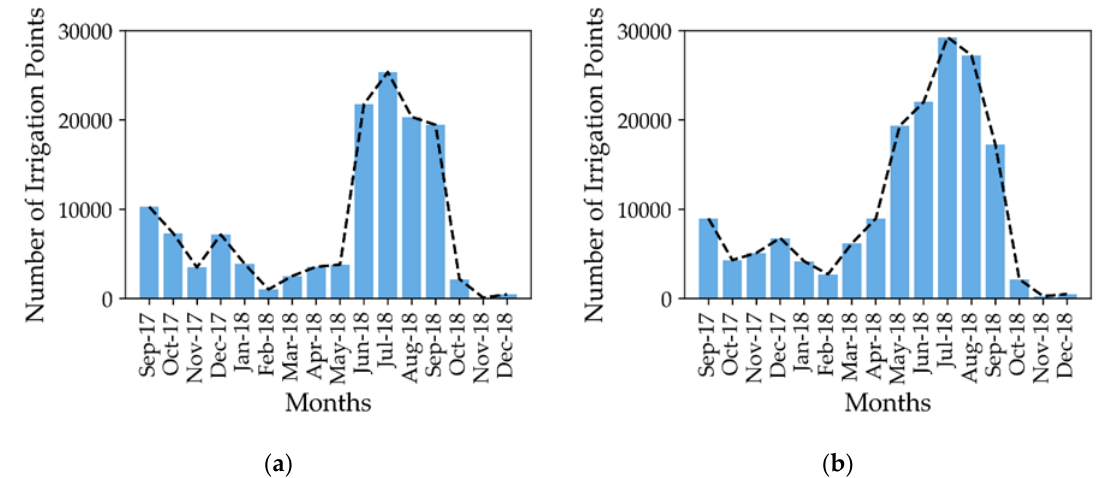
Figure 9. Distribution of the irrigation points detected over irrigated plots in Catalonia Spain as a function of months for ( a ) morning SAR acquisition, ( b ) evening SAR acquisition.